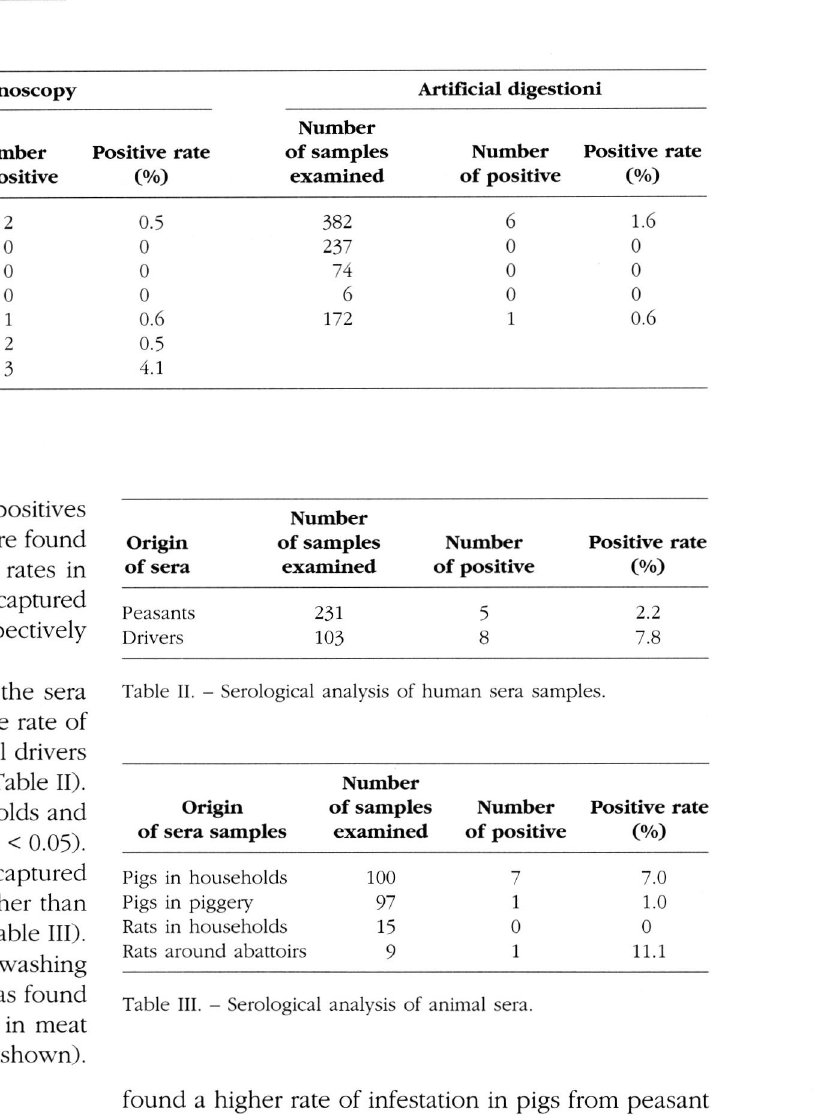
Table III. - Serological analysis of animal sera.